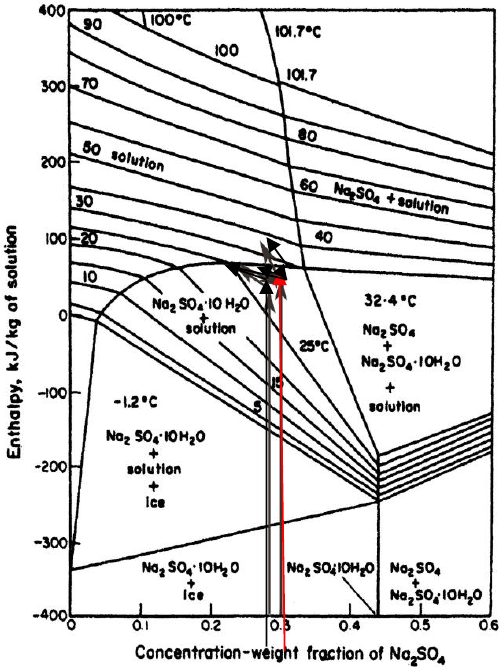
Figure 6. Enthalpy–concentration weight fraction temperature diagram from Mullin, J.W.: Crystal- lization, Fourth Edition, Reed Educational and Professional Ltd. Reproduced with permission from Butterworth–Heinemann, Oxford. There is risk of sulfate anhydrite and deposition to the right of the vertical line spanning the whole diagram. Location in this diagram of our experimental trials and % of water content in the solution are indicated by arrows. The red arrow shows how moving in the area of interest can effect where we are in diagram.